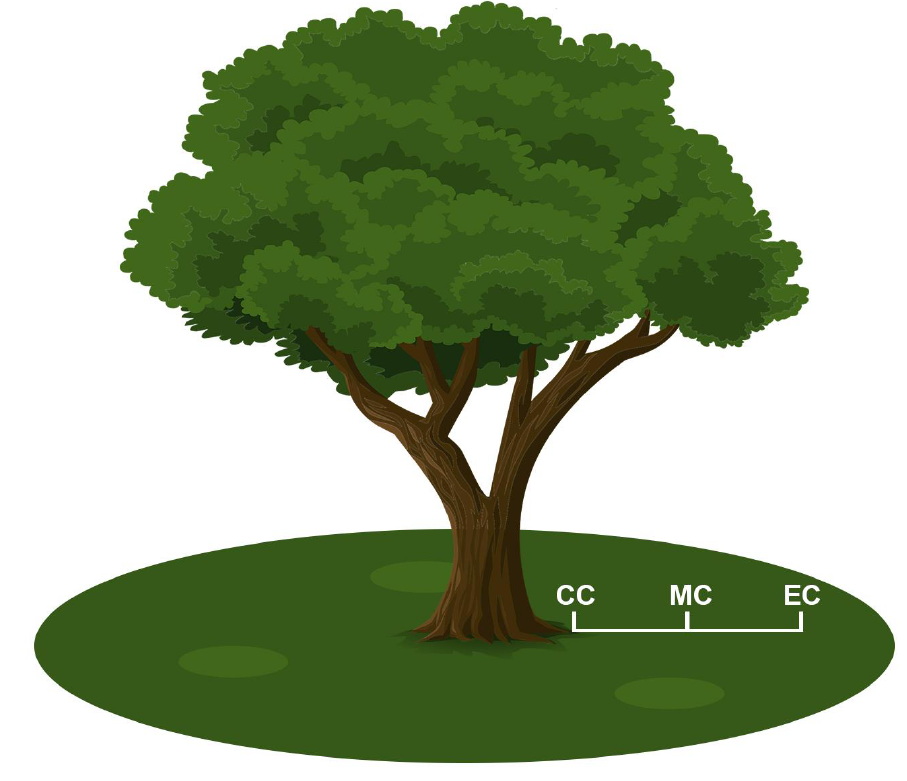
Figure 2. Sampling scheme: CC—the center of the crown, MC—the middle of the crown, EC—the edge of the crown.